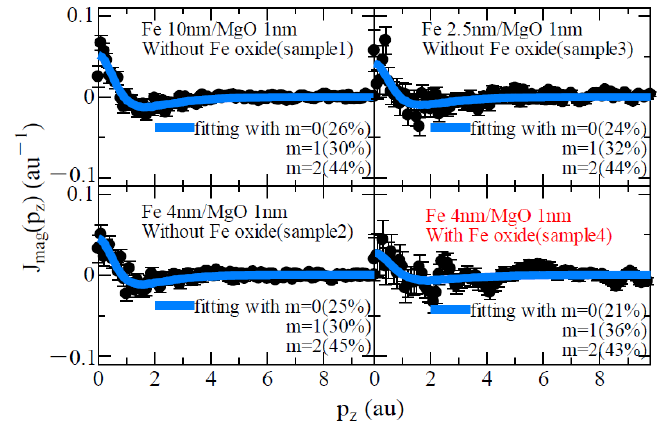
Figure 5. Anisotropies of Magnetic Compton profiles for Fe/MgO multilayered films obtained from Figure 4. Solid lines denote the fitting results explained later.